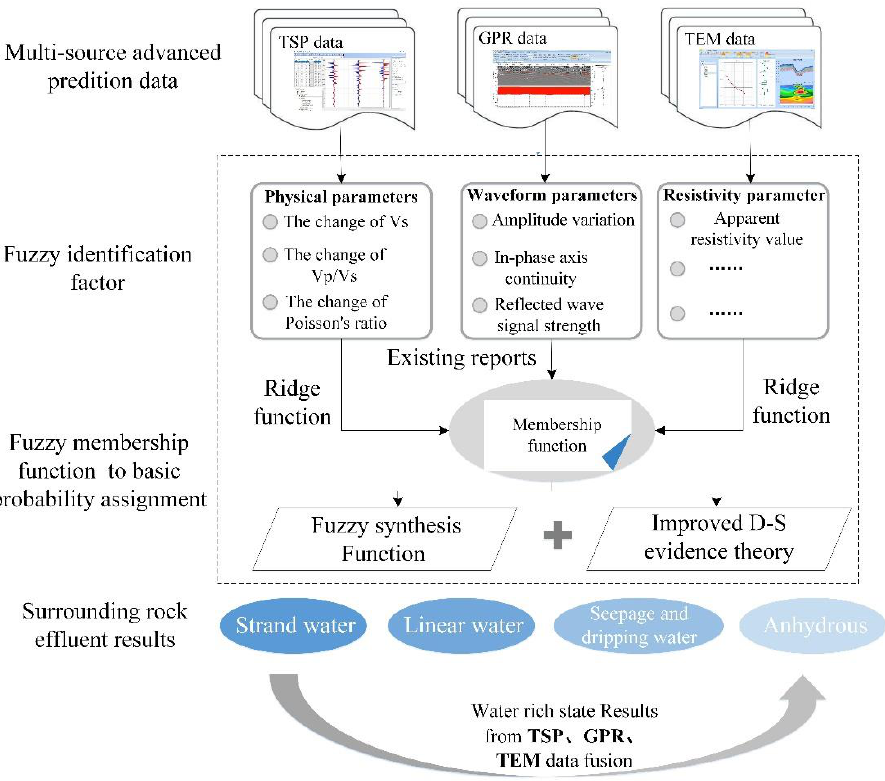
Figure 7. Transient electromagnetic prediction of the 305.2~+ 235 m mileage section. The input data consist of three types of geophysical data. Taking TSP data as an example, the fuzzy physical parameters used to judge water richness in TSP data are